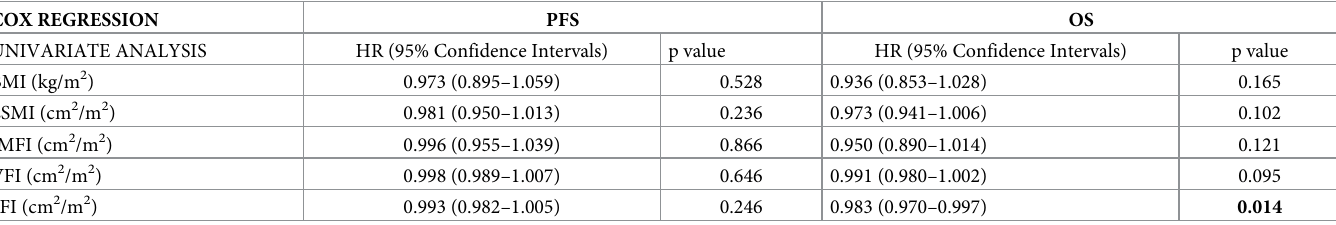
Table 3. Univariate analysis using Cox regression method investigating the hazard ratios of the BMI � , IMFI, VFI and SFI as continuous nominal variables (cm 2 /m 2 ) on PFS and OS. Gender was used as a stratification factor. COX REGRESSION PFS UNIVARIATE